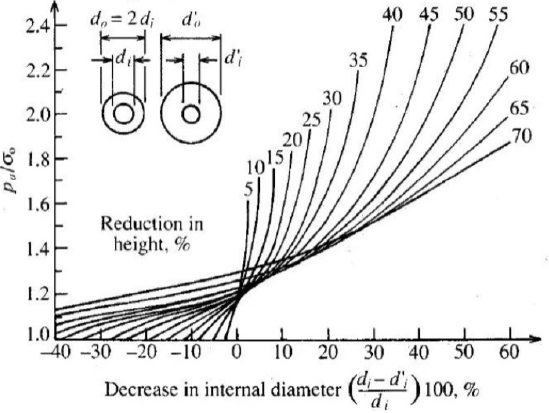
Figure 3: Analytical sigmoid curves for measuring the compressive stress using the ring compression test